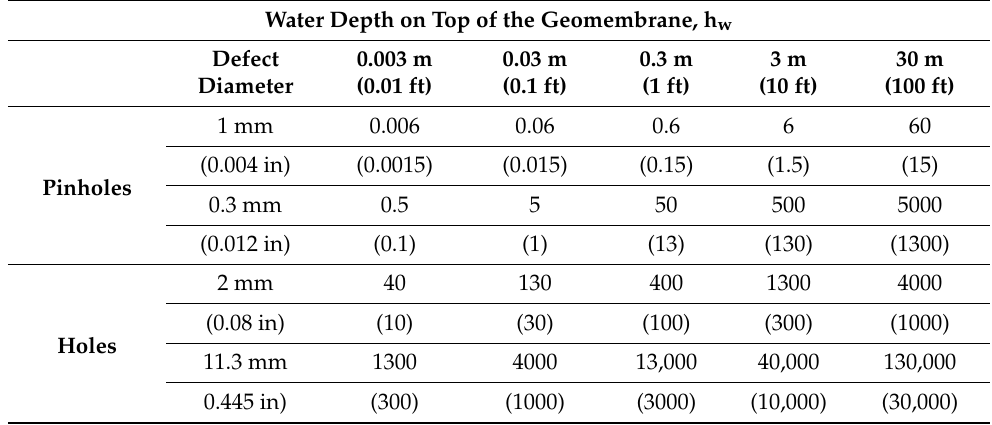
Table 6. Calculated leakage rates due to pinholes and holes in a geomembrane (1 mm) [39,40]. Water Depth on Top of the Geomembrane, h